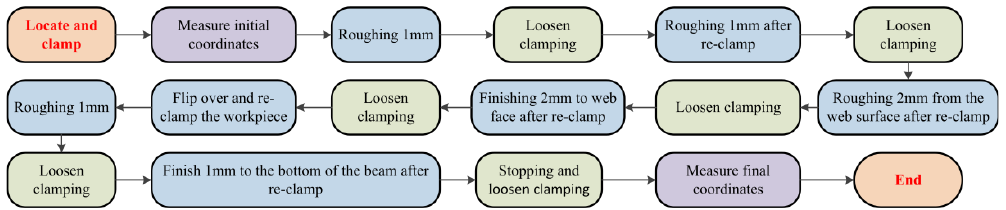
10 of 13 Figure 8. The structure and size of the thin-walled beam .